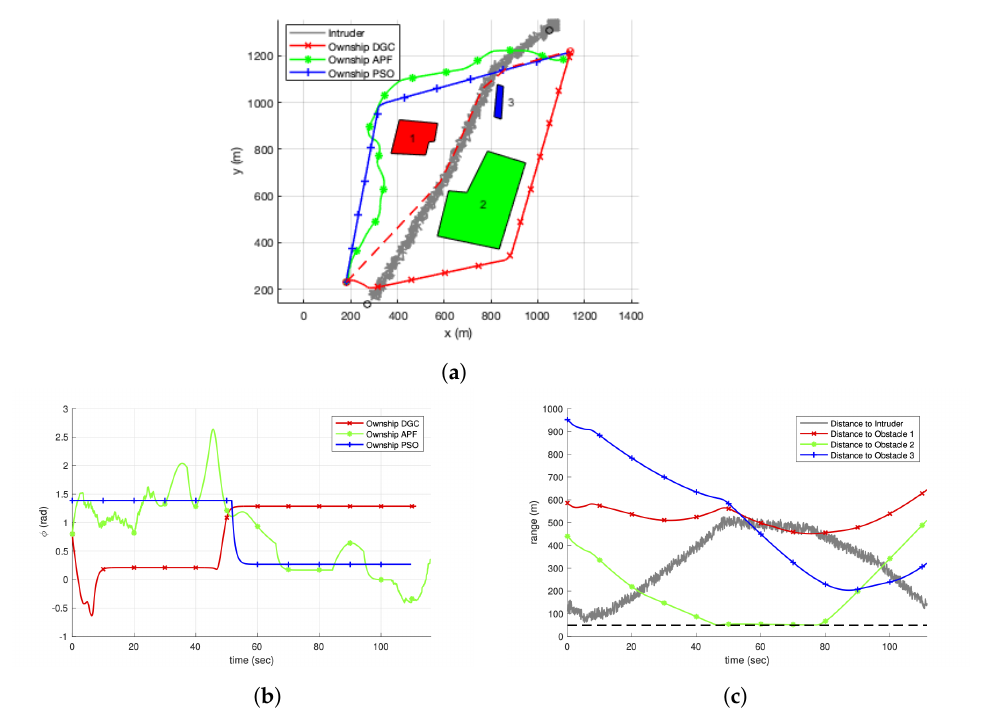
Figure 5. Single scenario comparison. ( a ) Trajectory. ( b ) Flight angle. ( c ) Distance to obstacles and